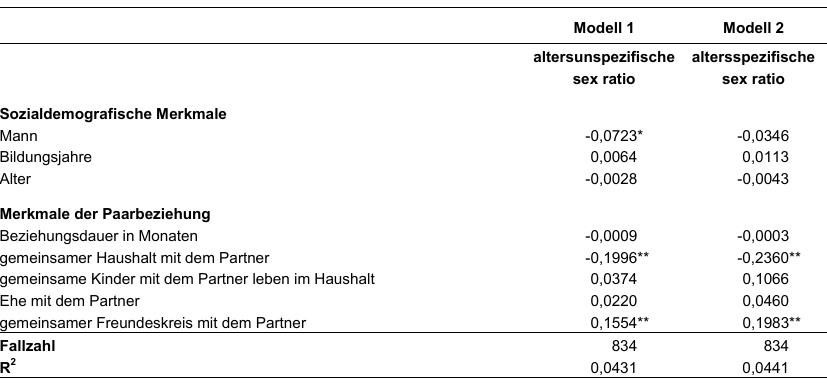
Tabelle 2 : Bestimmungsgründe der altersspezifischen und der altersunspezifischen sex ratio im Freundeskreis (lineare Regression). [b2]